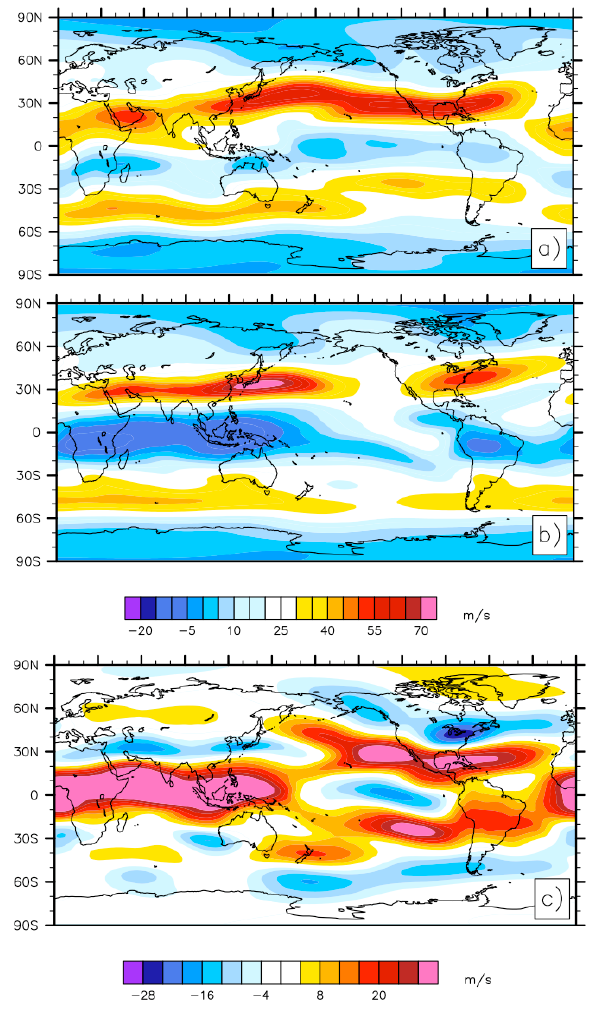
Fig. 7. Boreal winter average of mean wind (ms − 1 ) interpolated to the 200mb pressure level. (a) The NINO case, (b) MODERN case, and (c) difference between NINO and